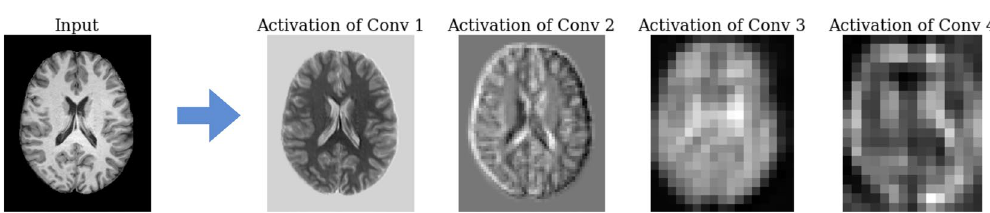
Figure 2. Comparison of the number of voxels each feature/kernel uses per model. The grid shows the entire input and in blue/green how much of the input is used in the respective models. Mass-univariate studies use a single voxel per classifier, fully-connected neural networks also use a single weight per voxel albeit combining them after. ROI-based models typically train a single classifier based on an entire ROI or extract a single feature from an ROI. Patch individual filter (PIF) neural networks use both the entire input for lower level features and patches for higher level (latent) features (shown in green). CNN filters use the entire input of each layer throughout the entire network (under some conditions regarding stride and dilation).